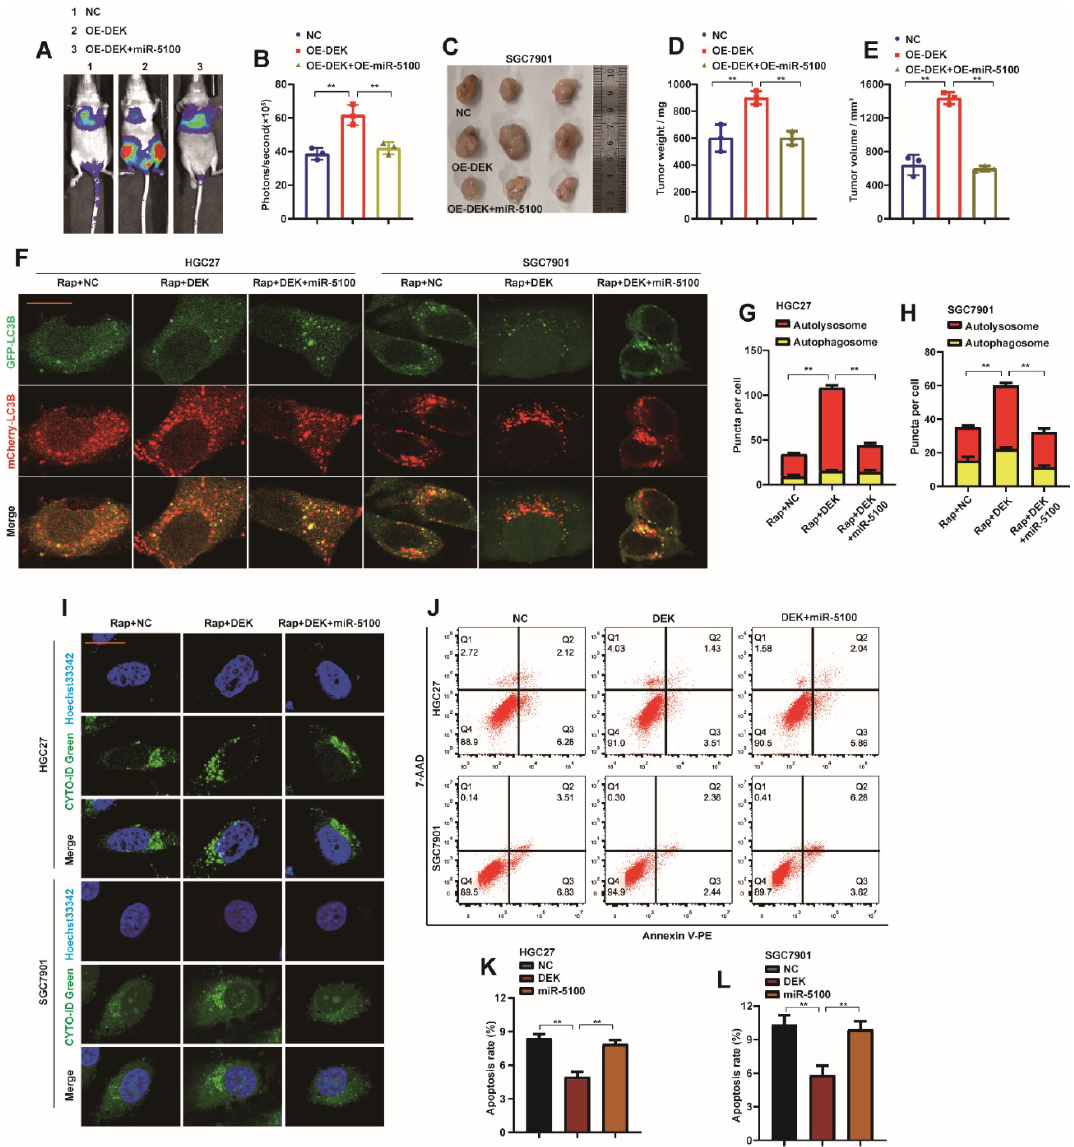
Figure 8. miR-5100 reverses the malignant phenotype of GC induced by abnormal expression of DEK. ( A , B ) pre-miR-5100 was introduced into SGC7901-DEK cell lines by lentiviral method, the resulting cell lines were labeled with luciferase, and then injected into nude mice by tail vein to detect the lungs of nude mice Department transfer situation. Statistical analysis of the fluorescence signal intensity was performed, ( n = 3, **: p < 0.01). ( C – E ) Pre-miR-5100 was introduced in SGC7901-DEK cell line, SGC7901-DEK/SGC7901-DEK + miR-5100 or control cell line was injected subcutaneously into nude mice, and subcutaneous xenografts were harvested and treated. Allograft mass and volume were statistically analyzed, (**: p < 0.01). ( F ) HGC27-DEK/SGC7901-DEK cells stably expressing mCherry-EGFP-LC3B were introduced with pre-miR-5100, respectively, and cells were treated with 5 nM Rap for 8 h, and the level of autophagic flux was observed under confocal microscopy. ( G , H ) Autophagosome (red dots) and Autolysosome (yellow dots) were analyzed, (**: p <0.01). ( I ) Pre-miR-5100 was introduced into HGC27-DEK/SGC7901-DEK cells, and the level of autophagy were observed under confocal microscopy after 5 nM Rap treatment for 8 h. ( J – L ) Pre-miR-5100 was introduced into HGC27-DEK/SGC7901-DEK cells, and the apoptosis level of the cells was detected by flow cytometry, and the results were statistically analyzed. ( n = 3,**: p < 0.01).